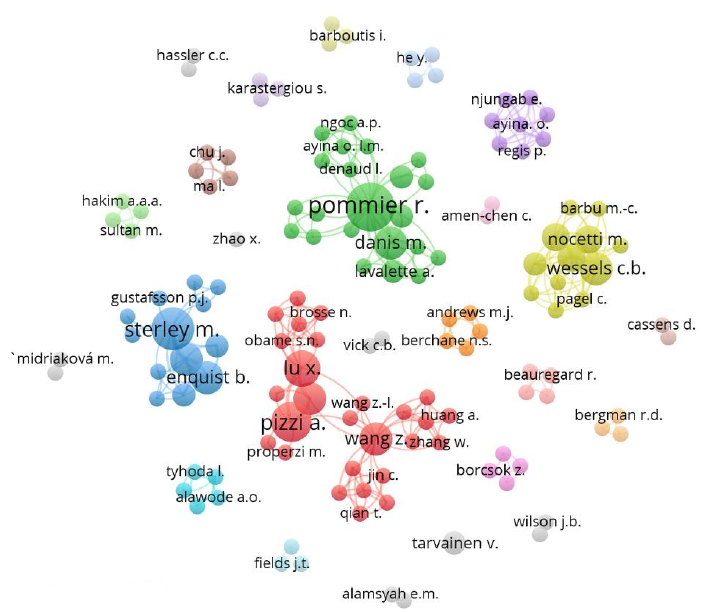
Figure 3. Network of co-authors of researchers in network visualization (VOSviewer).